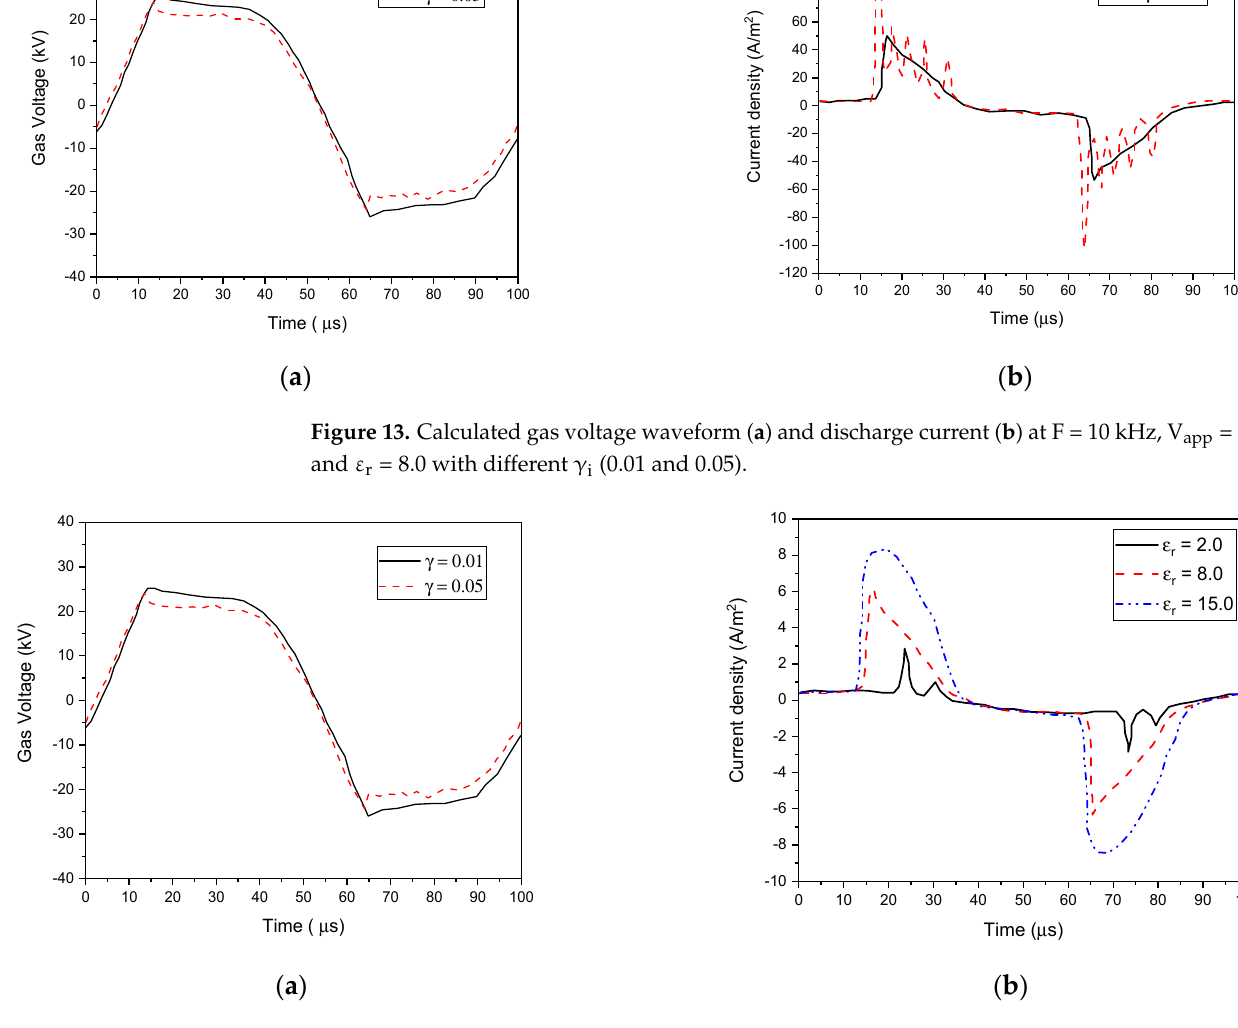
Figure 14. Calculated gas voltage waveform ( a ) and discharge current ( b ) at F = 10 kHz, V app = 30 kV, and γ i = 0.01 with different ε r (2, 8, and 15).